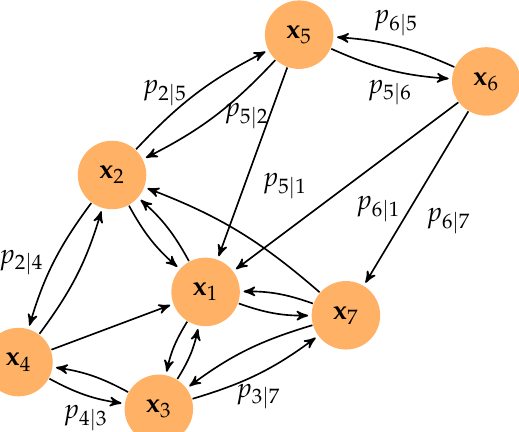
) and w = w ( x ) . The metric is the Euclidean distance. j i , x i j j